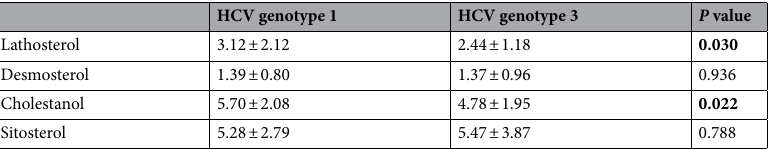
Table 2. Sterol markers of cholesterol synthesis (lathosterol and desmosterol) and absorption (cholestanol and sitosterol) in fasting sera (cohort 1) (µmol/L). Significant values are in bold.